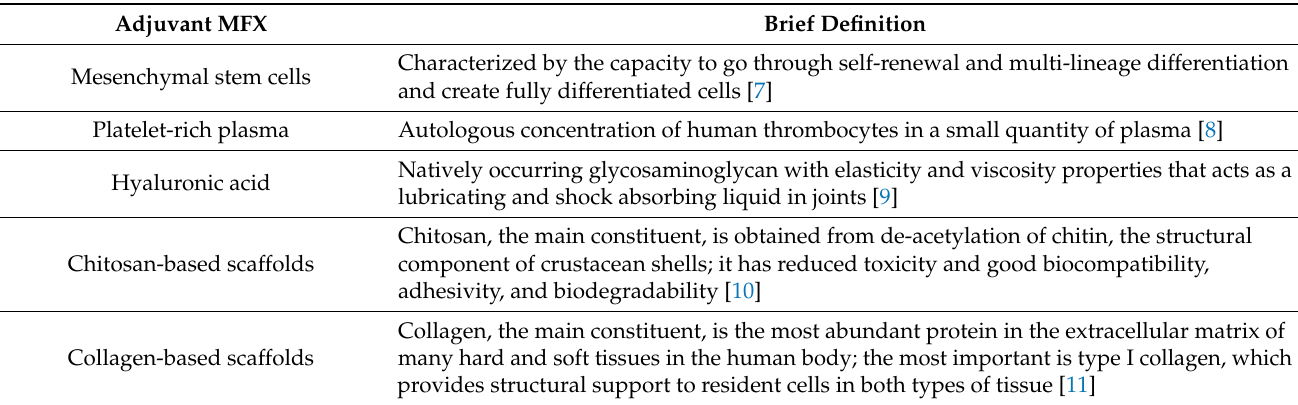
Table 1. The main adjuvant treatments with MFX.